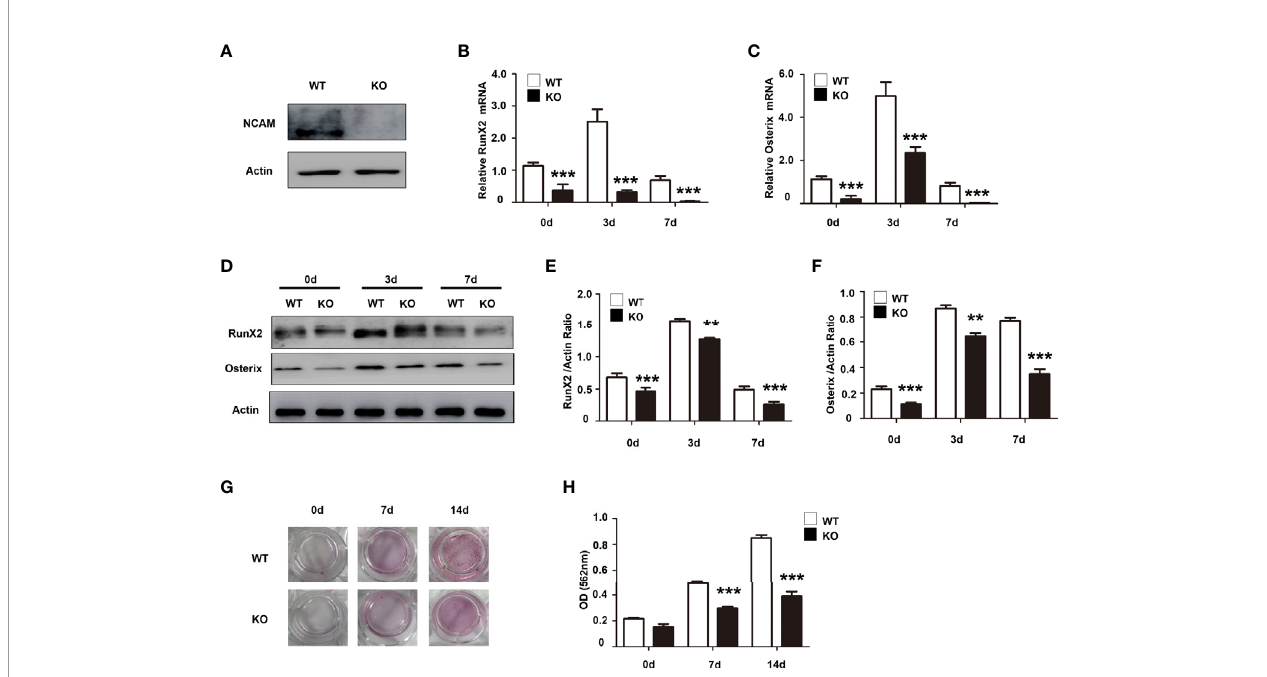
FIGURE 2 | NCAM de fi ciency inhibits osteoblast differentiation of mouse MSCs. (A) Wild-type (WT) and Ncam – / – (KO) MSCs were examined with anti-NCAM antibody. b -actin was detected as a loading control. The expression of RunX2 (B) and Osterix (C) was analysed by real-time PCR (The data are expressed as the mean ± SEM of three independent experiments. *** p < 0.001, compared with WT MSCs). (D) The expression of RunX2 and Osterix was analysed by immunoblotting, b -actin was detected as a loading control. Levels of RunX2 (E) and Osterix (F) were quanti fi ed by densitometry and normalized to b -actin (Data are representative of three independent experiments and values are means ± SEM. ** p < 0.01, *** p < 0.001, compared with WT MSCs). (G) Calcium deposition of differentiated WT and KO MSCs was assessed by Alizarin red staining. (H) The Alizarin red staining was extracted and quanti fi ed, the wavelength was measured at 562 nm (Data are representative of three independent experiments and values are means ± SEM. *** p < 0.001, compared with WT